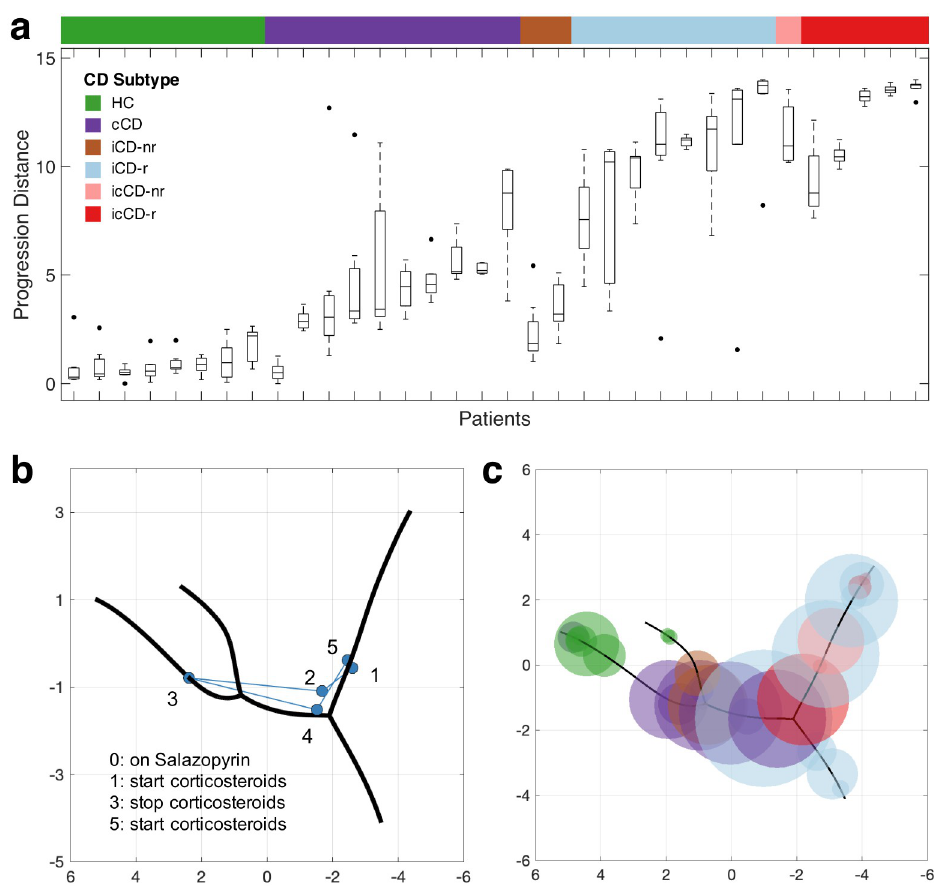
Fig 6. Microbial community dynamics analysis of individual patients. ( a ) The progression distances of the samples collected from individual participants over a two-year period. The participants were first ordered by CD subtypes and then by median progression distances. ( b ) The microbiome composition of a patient was significantly altered by medication. Sample 0 contained only a few hundreds of reads and thus was omitted. ( c ) Samples collected from a two- year study provided only a partial picture of microbial community dynamics associated with disease development. Each circle represents a patient, the face color represents the CD subtype, and the radius equals 1.5 MAD of the progression distances of the samples collected from the patient. MAD: median absolute